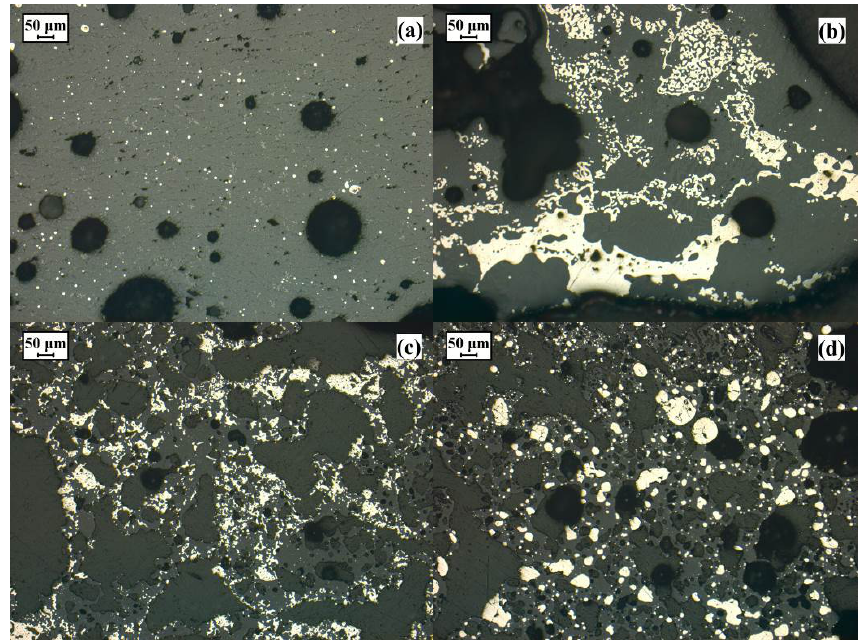
Figure 9. Distributions of iron grains in reduced pellets under different coal ‐ bearing mass ratios (( a , b ) inner and outer layer without coal ‐ bearing; ( c , d ) inner and outer layer with a 15% coal ‐ bearing mass ratio).